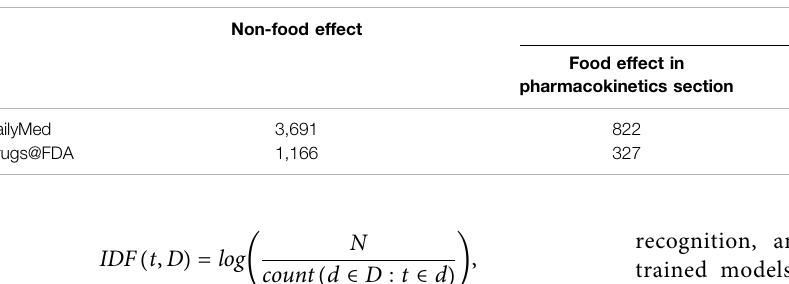
TABLE 3 | Statistical Summary of Food Effect/Non-Food Effect Data Extracted by Keyword Detection and Regular Expression. The numbers represent the number of